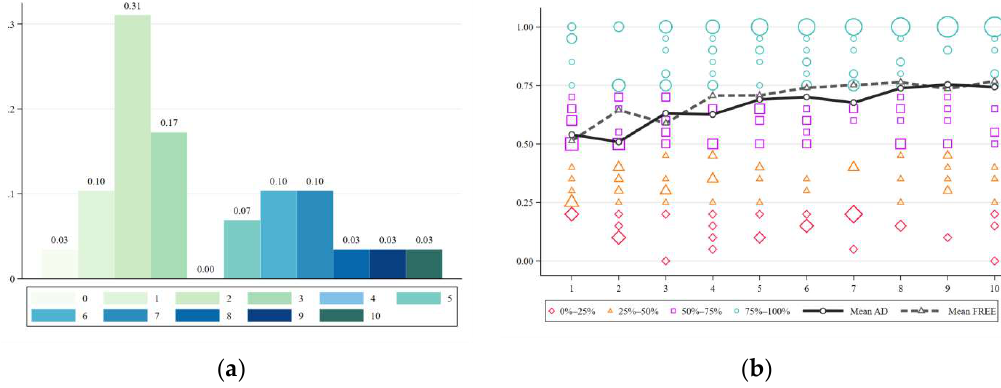
Figure 3. ( a ) Histogram of advice scores for player B, ( b ) investment made by player A in the AD treatment. Circles represent choices above 75% of the total, squares represent choices of 50%–75%, triangles represent choices of 25%–50%, and diamonds represent choices below 25%. The solid (dashed) line portrays the mean choices per period in the AD (FREE).